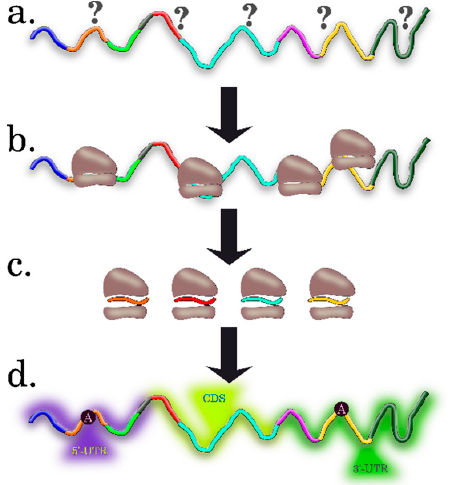
Figure 3. Scheme of application of ribosome profiling to functional characterization of mRNA regions. ( a ) Scheme of an mRNA with unknown ribosome positions. ( b ) The mRNA with arrested ribosomes in the transcript regions potentially important for efficient translation. ( c ) Formation of the ribosome footprints by RNase hydrolysis. The resulting footprints characterize the translational functionality of a certain mRNA region. The footprints shown with different colors correspond to different mRNA regions. ( d ) Result of analysis of the precise positions of translating ribosomes along mRNA, where A is the identified alternative open reading frames in 5’UTRs or 3’UTRs and CDS (coding sequence) is the main reading frame of the transcript.